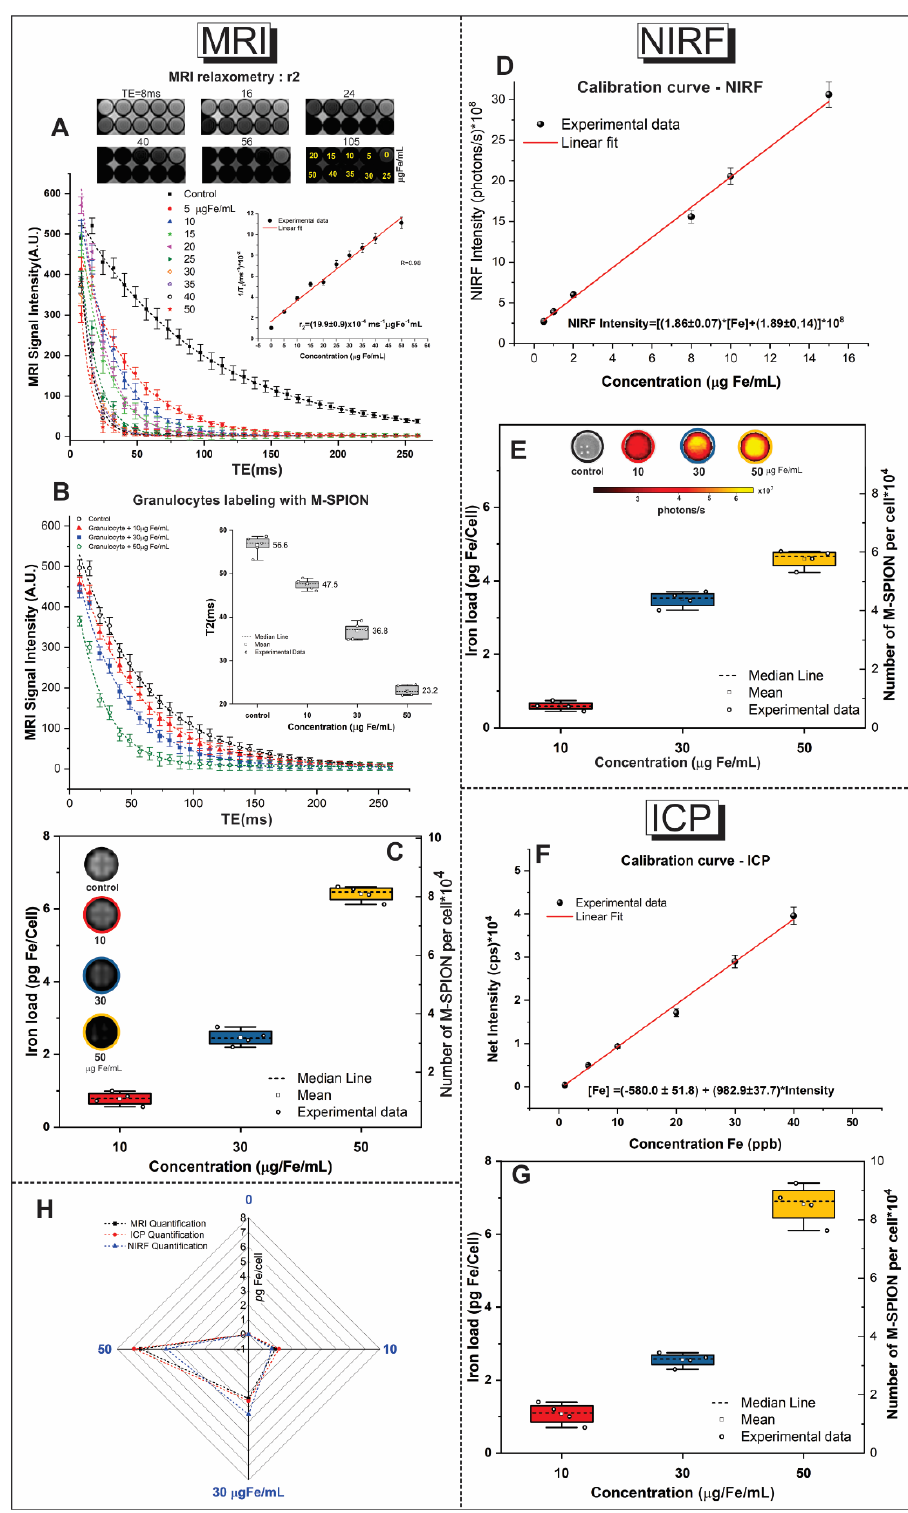
Figure 5. The quantification of M-SPIONs internalization into granulocytes. ( A ) MRI of the phantom containing different M-SPION concentrations and graph demonstrating the transverse relaxation curves of the signal intensity MRI as a function of echo time for M-SPION concentrations of 5, 10, 15, 20, 25, 30, 35, 40 and 50 µg Fe/mL. The inset image shows the r2 value determined from the linear adjustment of inverse transverse relaxation time as a function of iron concentration. ( B ) The graph of the signal intensity of MRI as a function of echo time for the samples of granulocytes labeled with M- SPION concentrations of 10, 30 and 50 µg Fe/mL. The inset shows the boxplot of the T2 value as a function of iron concentration used in each sample. ( C ) The boxplot of the iron load quantified by the